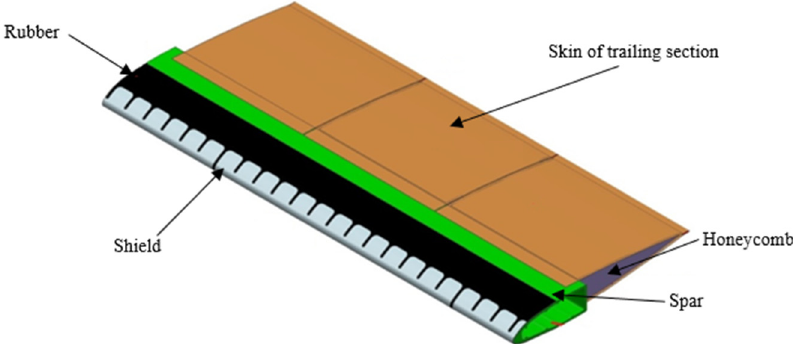
Figure 1. Structural baseline model of a Mi helicopter rotor blade.